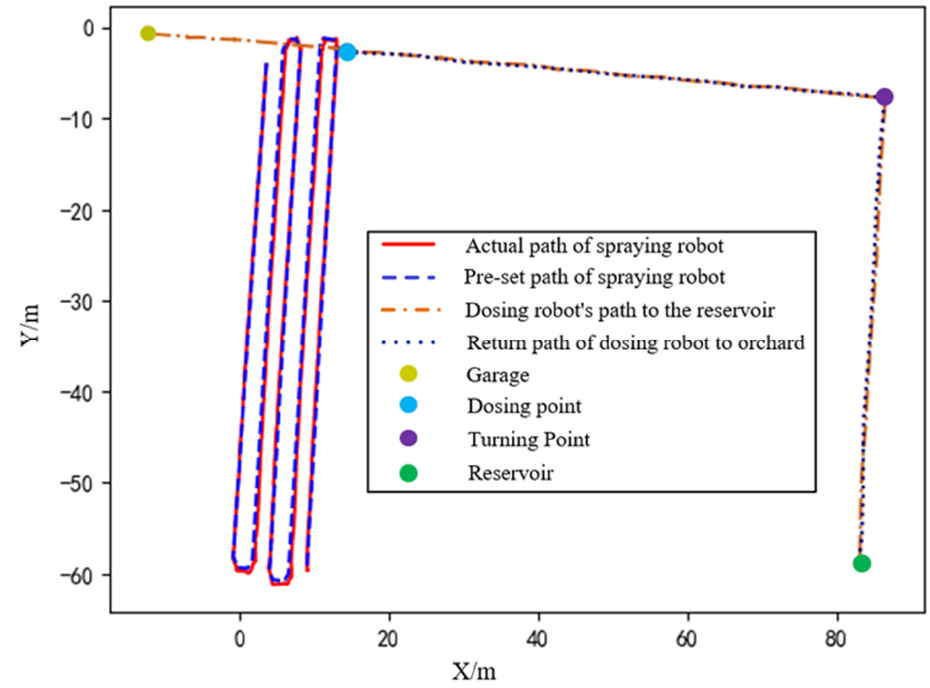
Figure 20. Movement trajectory of spraying–dosing robot group.